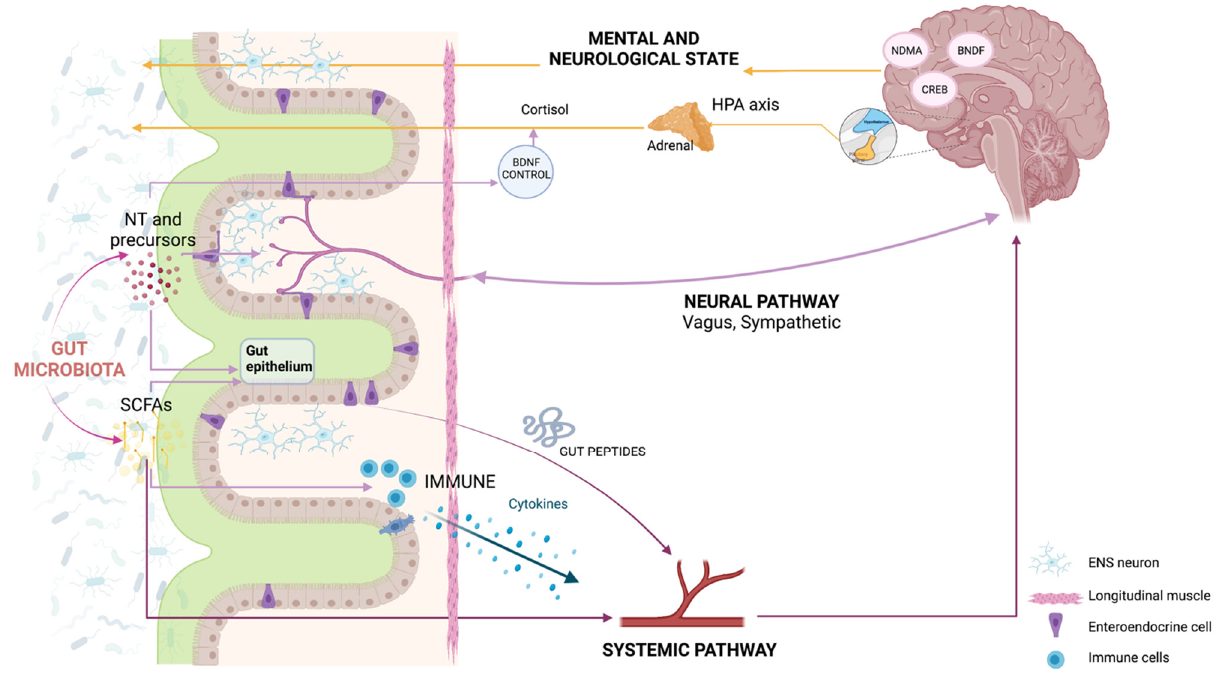
Figure 1. Communication pathways and mechanistic links between gut microbiota and brain plasticity. The microbiota– gut–brain axis comprises a complex bidirectional communication system mediated by neural (central nervous system, enteric nervous system (ENS), and branches of the sympathetic and parasympathetic systems), immune, endocrine, and humoral pathways. BDNF: brain-derived neurotrophic factor; CREB: cAMP-response element binding protein; HPA: hypothalamic–pituitary–adrenal; NMDA: N-methyl-D-aspartate; SCFAs: short-chain fatty acids. Created with BioRender.com (accessed on 25 July 2021).